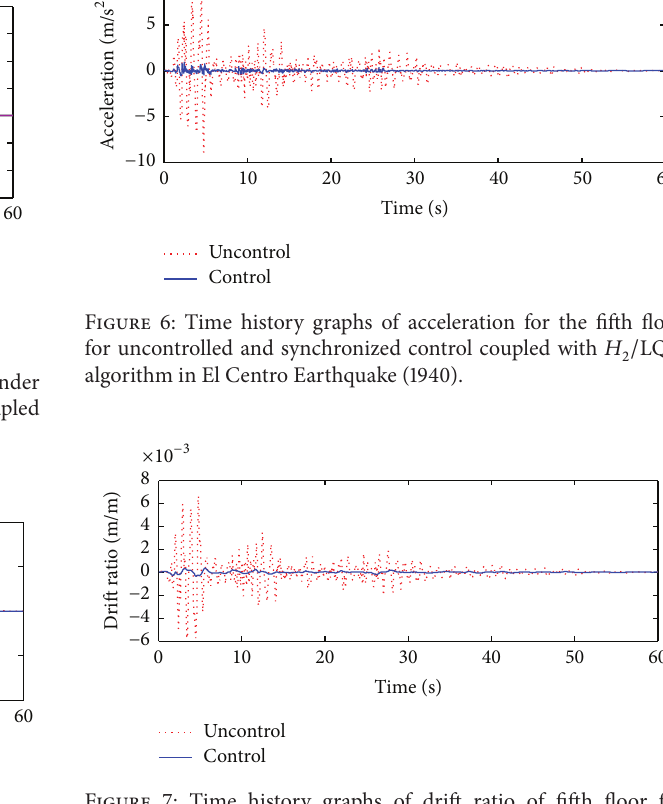
Figure 7: Time history graphs of drift ratio of fifth floor for uncontrolled and synchronized control coupled with 𝐻 2 / LQG algorithm in El Centro Earthquake